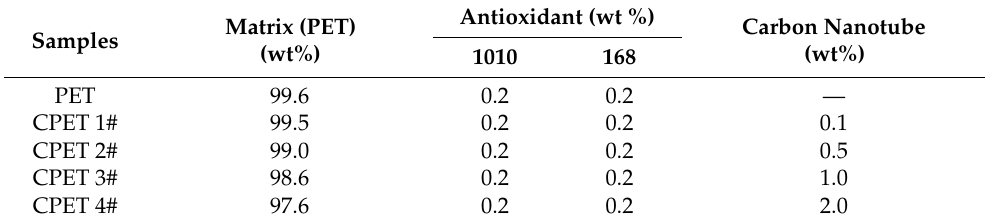
Figure 1. Schematic diagram for the process of CNT/PET pellets. Table 1. CNT/PET mass ratio of composite